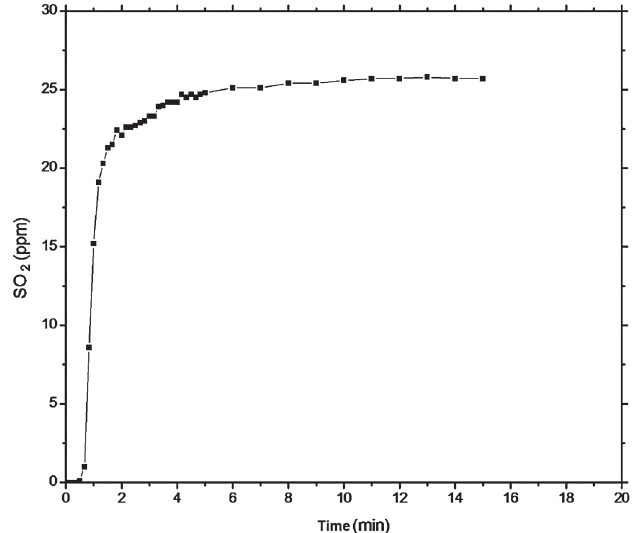
Figure 5 - Evolution of SO